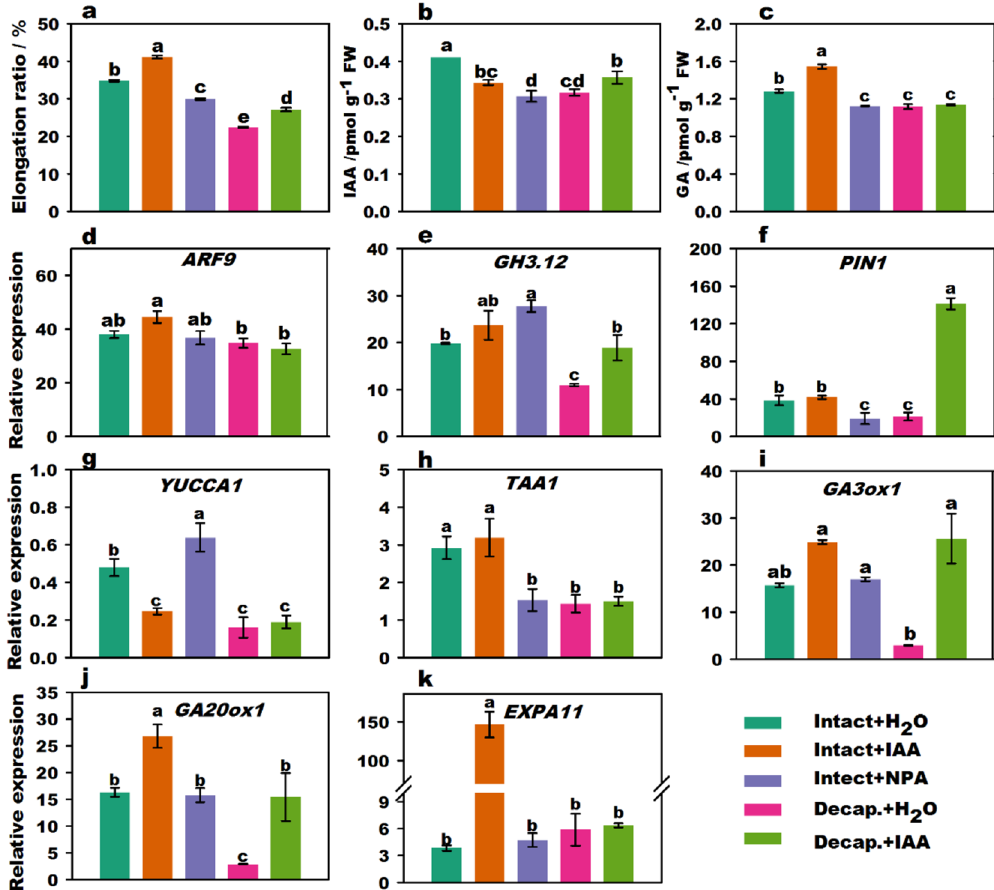
Figure 1. Effect of IAA treatments on stalk elongation, endogenous hormone content, and related gene expression of flowering Chinese cabbage. Stalk elongation ratio of flowering Chinese cabbage ( a ). Changes in endogenous IAA ( b ) and GA ( c ) content in stalk tips treated with different phytohormones. The relative expression of signal transduction ( d , e ) genes, polar transport genes ( f ), IAA biosynthesis ( g,h ), GA biosynthesis ( i , j ), and cell expansion ( k )-related genes under different phytohormone treatments. Values with different letters indicate significant differences at p < 0.05, according to Duncan’s multiple range tests. Error bars indicate standard errors of three biological replicates. Decap . decapitation